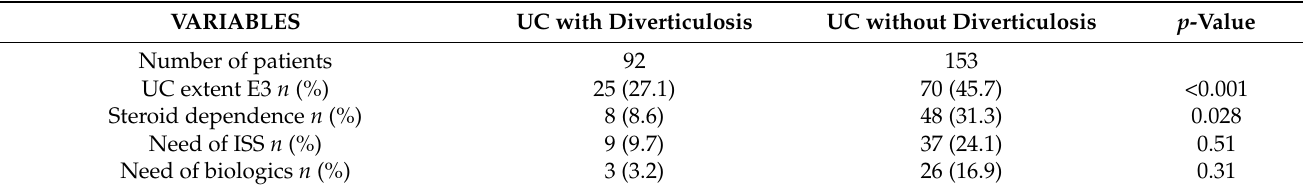
Table 3. Multivariate analysis of factors differently associated with ulcerative colitis (UC) patients with or without concomitant colonic